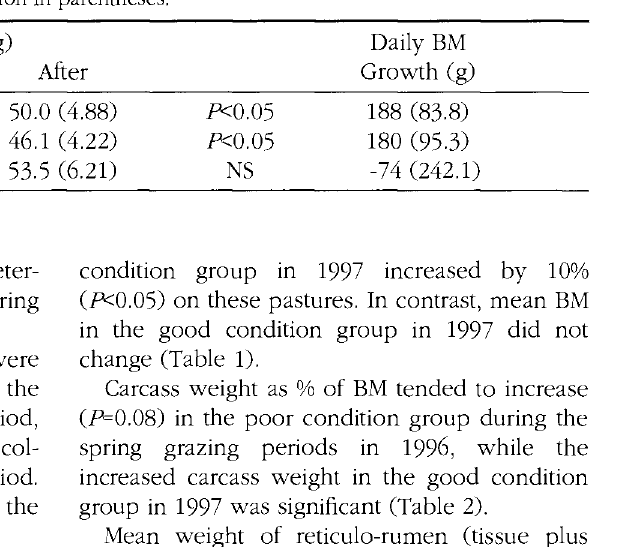
Table 1. Body mass (BM) and growth data in male reindeer yearlings before (7 and 14 June) and after grazing (1 and 7 July) coastal old meadow in spring in 1996 (poor condition group) and 1997 (poor and good condi tion groups), respectively. Standard deviation in